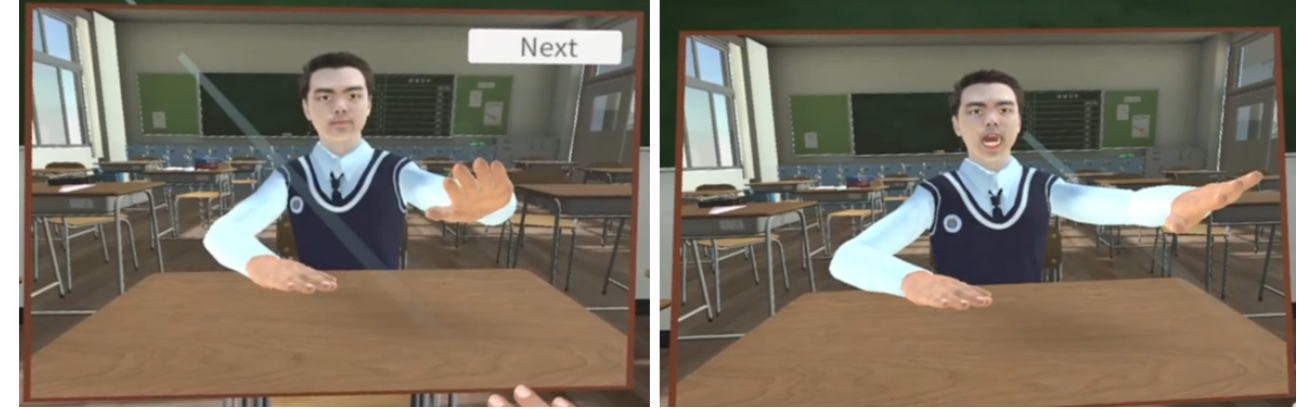
Figure 4. The virtual mirror in the embodiment scene.